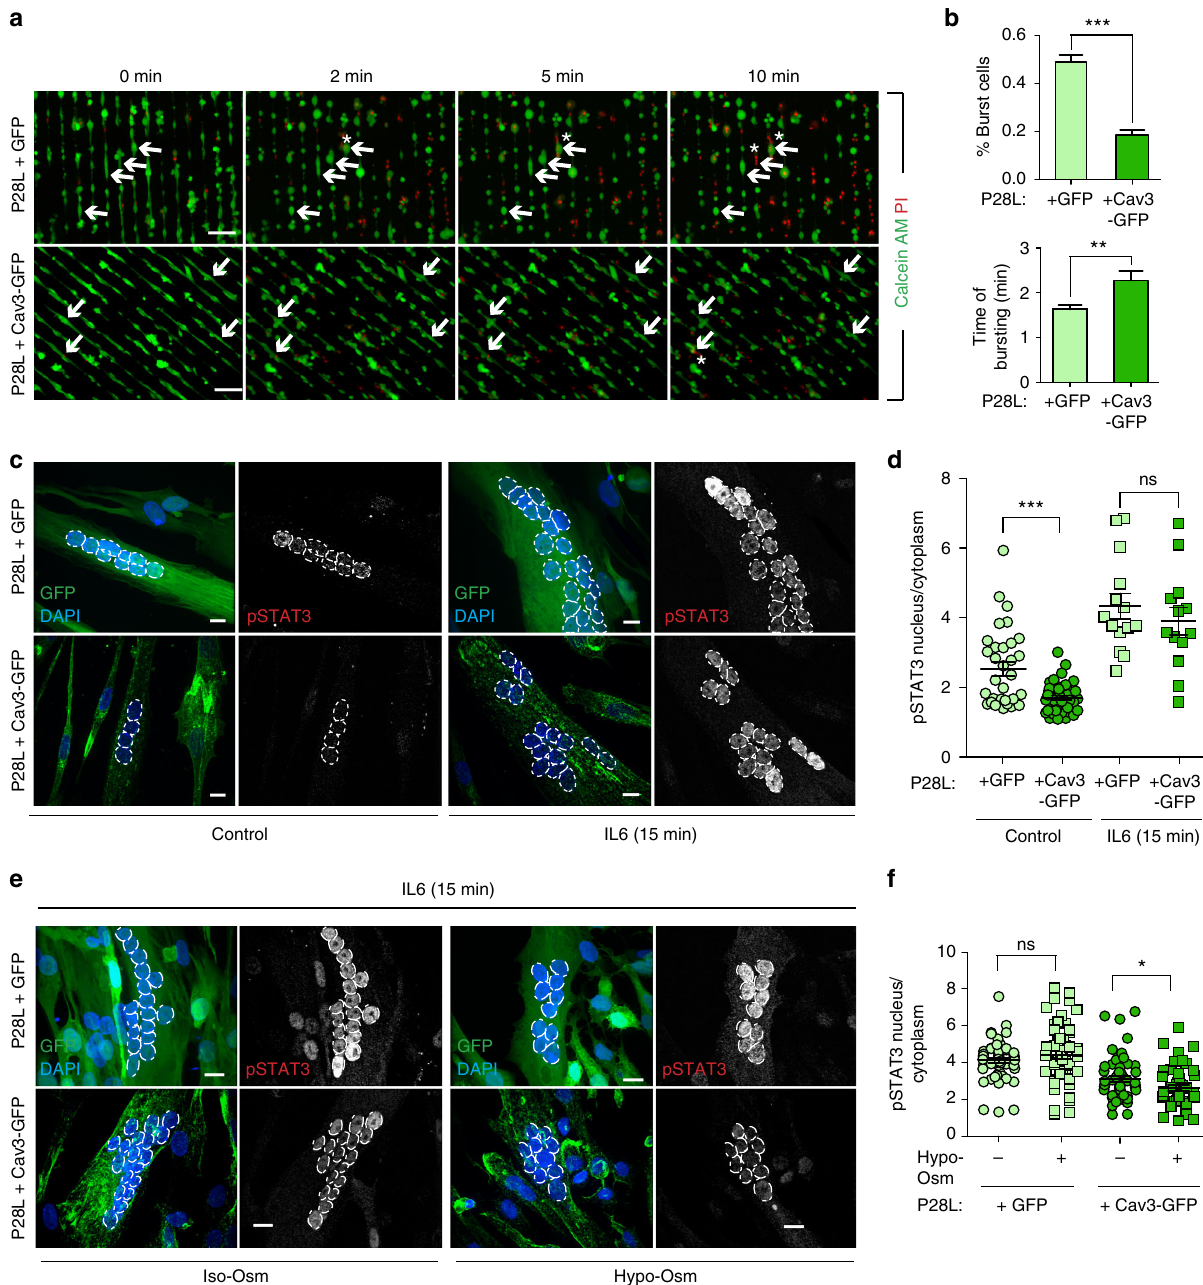
Fig. 6 Expression of WT Cav3 rescues a normal phenotype in Cav3 P28L myotubes. a Micropatterned P28L GFP and P28L Cav3-GFP transduced myotubes were loaded with calcein-AM (green). The medium was switched with a 30 mOsm medium supplemented with propidium iodide (PI, red). Representative pictures were taken at the indicated times during hypo-osmotic shock. Arrows correspond to myotubes and asterisks correspond to burst myotubes. b Quanti fi cation of the percentage of burst myotubes (upper panel) and mean time of bursting in minutes (lower panel) in a . c Confocal microscopy of immuno fl uorescent pSTAT3 in P28L GFP or P28L Cav3-GFP transduced myotubes stimulated or not with 10 ng mL − 1 IL6 for 15 min. White dashed lines outline nucleus boundaries. d Quanti fi cation of pSTAT3 nuclear translocation in c corresponding to nuclei/cytoplasm mean intensity ratio of pSTAT3. e Confocal microscopy of immuno fl uorescent pSTAT3 in P28L GFP or P28L Cav3-GFP transduced myotubes subjected or not to a 75 mOsm hypo-osmotic shock (Hypo-Osm) for 5 min, followed by stimulation with 10 ng mL − 1 IL6 for 15 min. White dashed lines outline nucleus boundaries. f Quanti fi cation of pSTAT3 nuclear translocation in e corresponding to nuclei/cytoplasm mean intensity ratio of pSTAT3. a Scale bar = 120 µ m. c , e Scale bar = 10 µ m. Reproducibility of experiments: a Shows representative data of 3 experiments quanti fi ed in b (% burst cells: GFP n = 353 cells and Cav3-GFP n = 358 cells; time of burst: GFP n = 175 cells and Cav3-GFP n = 65 cells). c Shows representative data of 3 experiments quanti fi ed in d (control: GFP n = 33 cells and Cav3-GFP n = 42 cells; 15 min: GFP n = 14 cells and Cav3-GFP n = 13 cells). e Representative data of 3 experiments quanti fi ed in f (Iso-Osm: P28L GFP n = 58 cells, P28L Cav3-GFP n = 60 cells; Hypo-Osm: P28L GFP n = 57 cells, P28L Cav3-GFP n = 52 cells). Mean value ± SEM. b Statistical analysis with two- tailed paired t test. d , f Statistical analysis with one-way ANOVA; * P < 0.05; ** P < 0.01; *** P < 0.001; ns non-signi fi